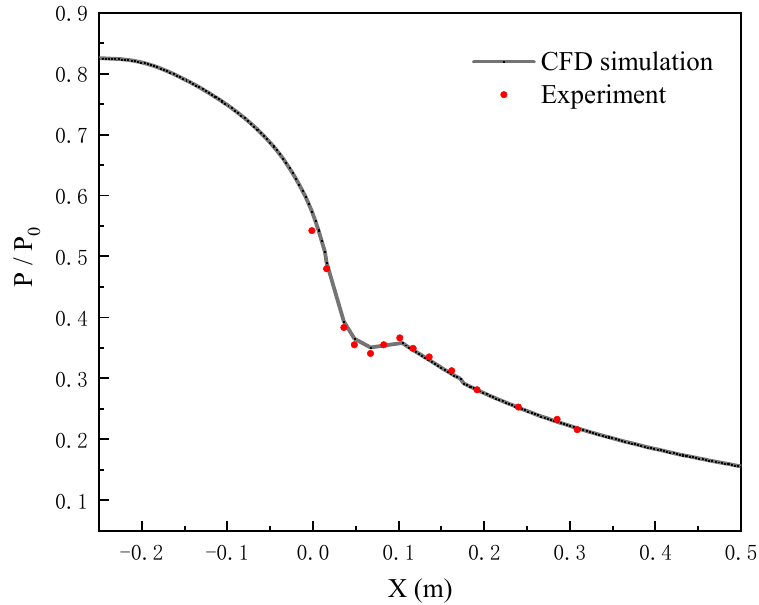
Figure 3. Pressure distribution along the Moore type “B” nozzle centerline as compared with exper-